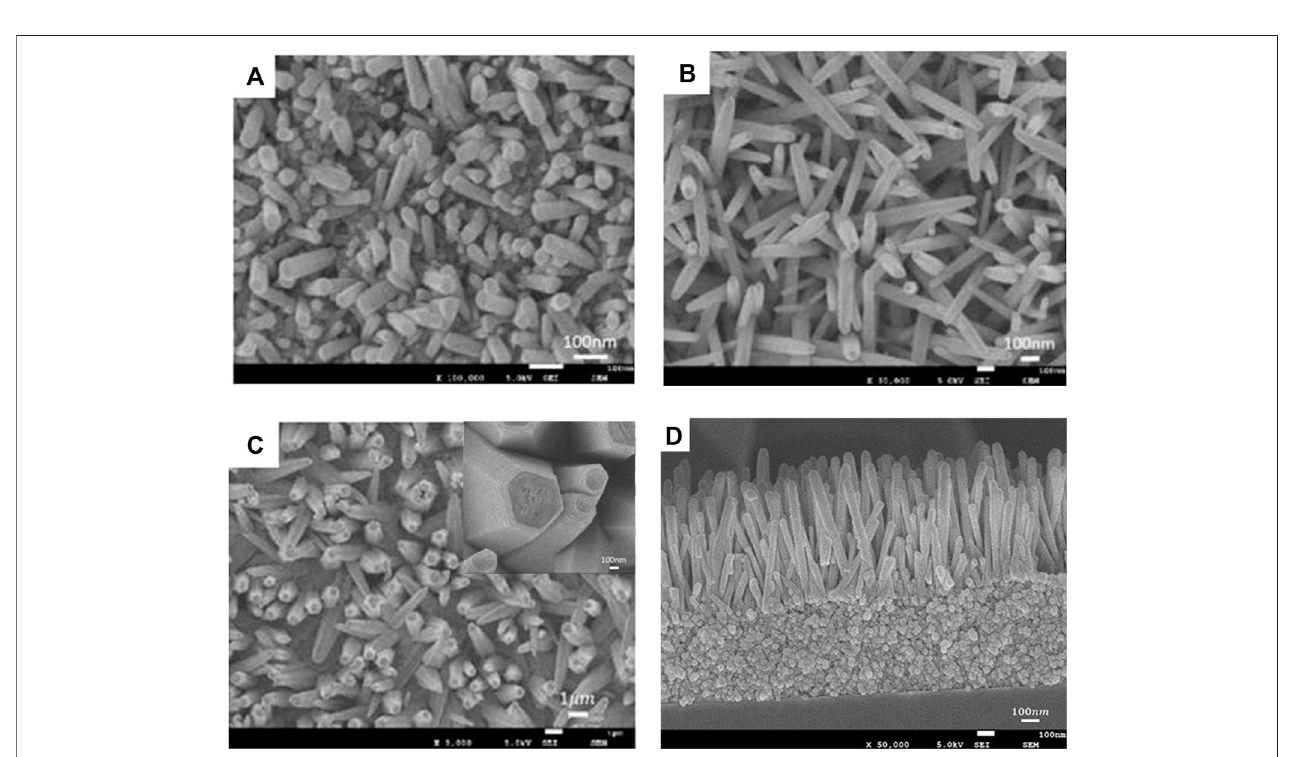
FIGURE5| SEMimagesoftheZnOnanorodsonthegraphenesheetswithzincnitratehexahydrate of25 mMandthereactiontimeof3 h (A) ,4 h (B) ,and5 h (C) , respectively.